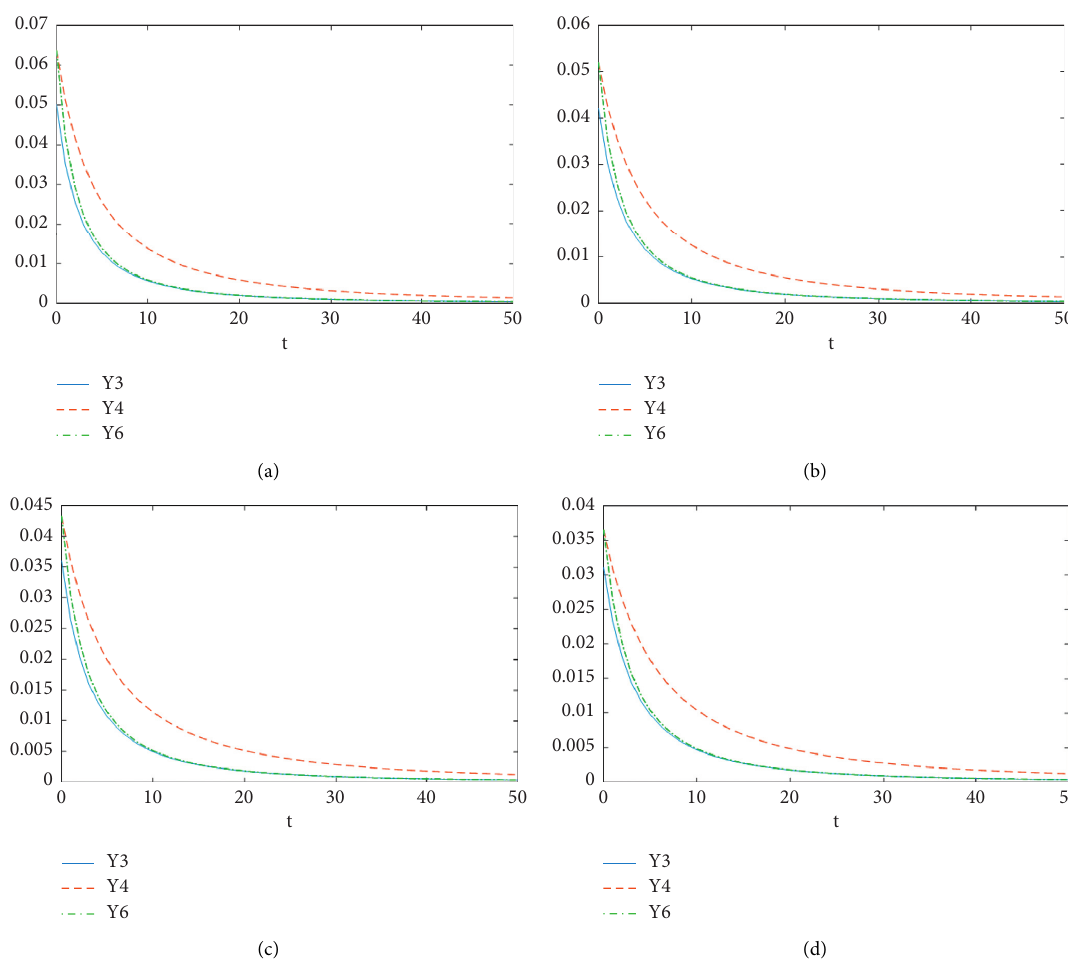
Figure 5: Balanced carbon emissions before and after the integration of Situation III and Situation IV ( s β � 0 . 4. (c) β � 0 . 6. (d) β � 0 .